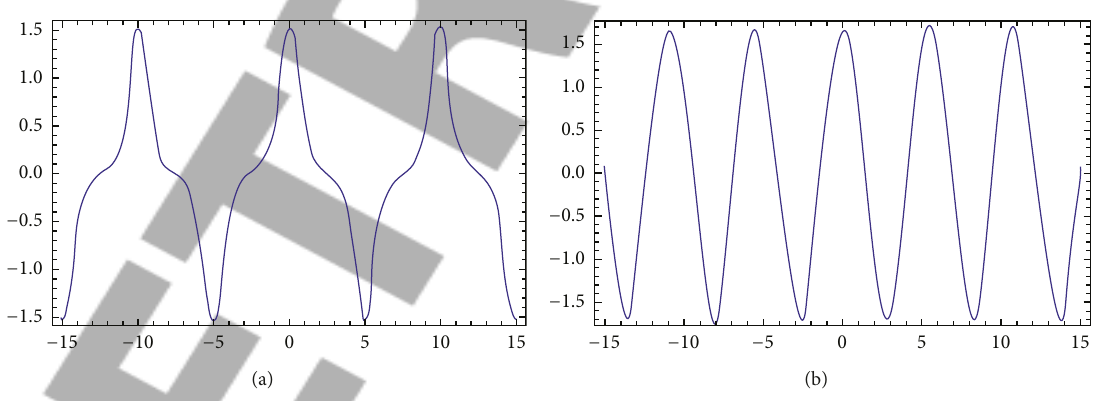
Figure 8: Simulation of periodic waves corresponding to periodic orbits outside figure-eight loop of (7). (a) Close to figure-eight loop. (b) Far from figure-eight